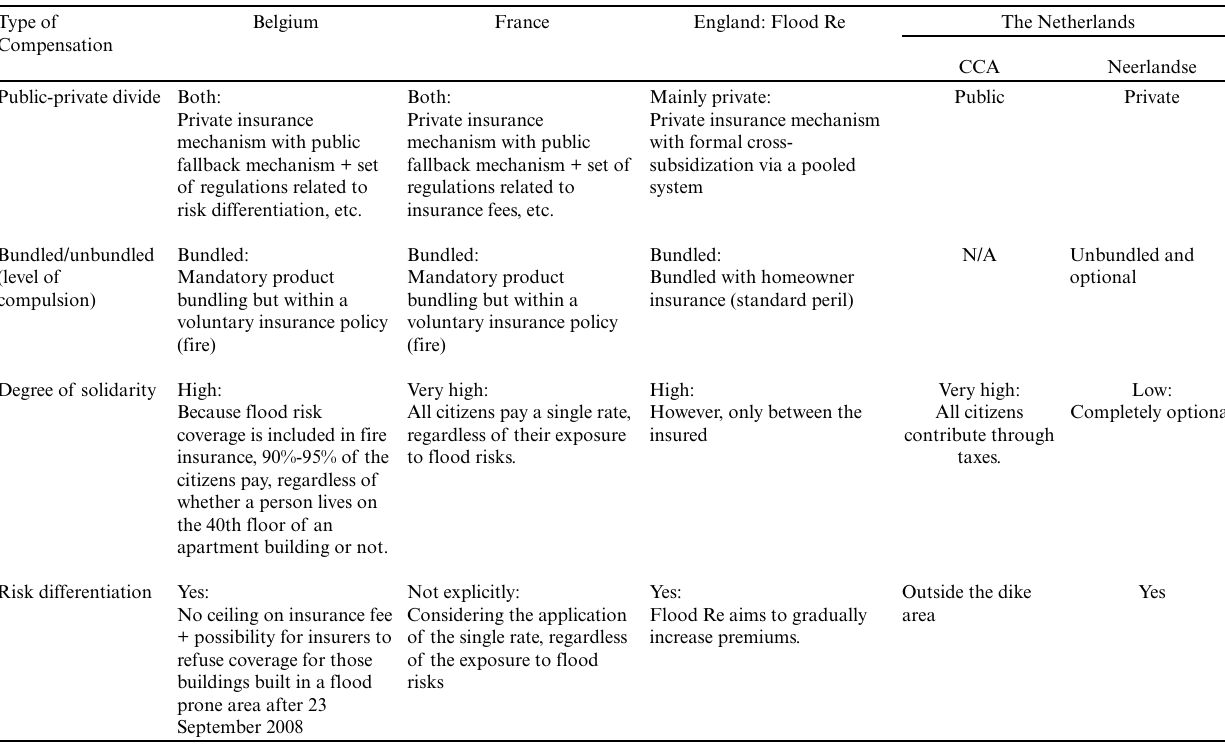
Table 2 . Overview of ex post compensation mechanisms for floods in the selected